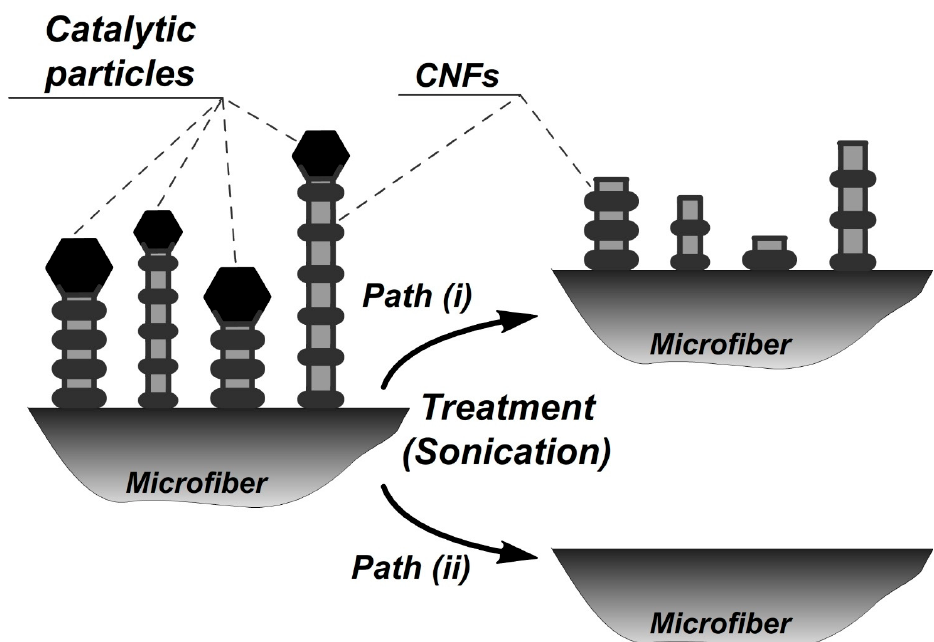
Figure 7. Schematic illustration of different sonication effects, which can be distinguished by means of TEM visualization: path (i)—breakage of CNFs; path (ii)—detachment of CNF from the microfiber surface.